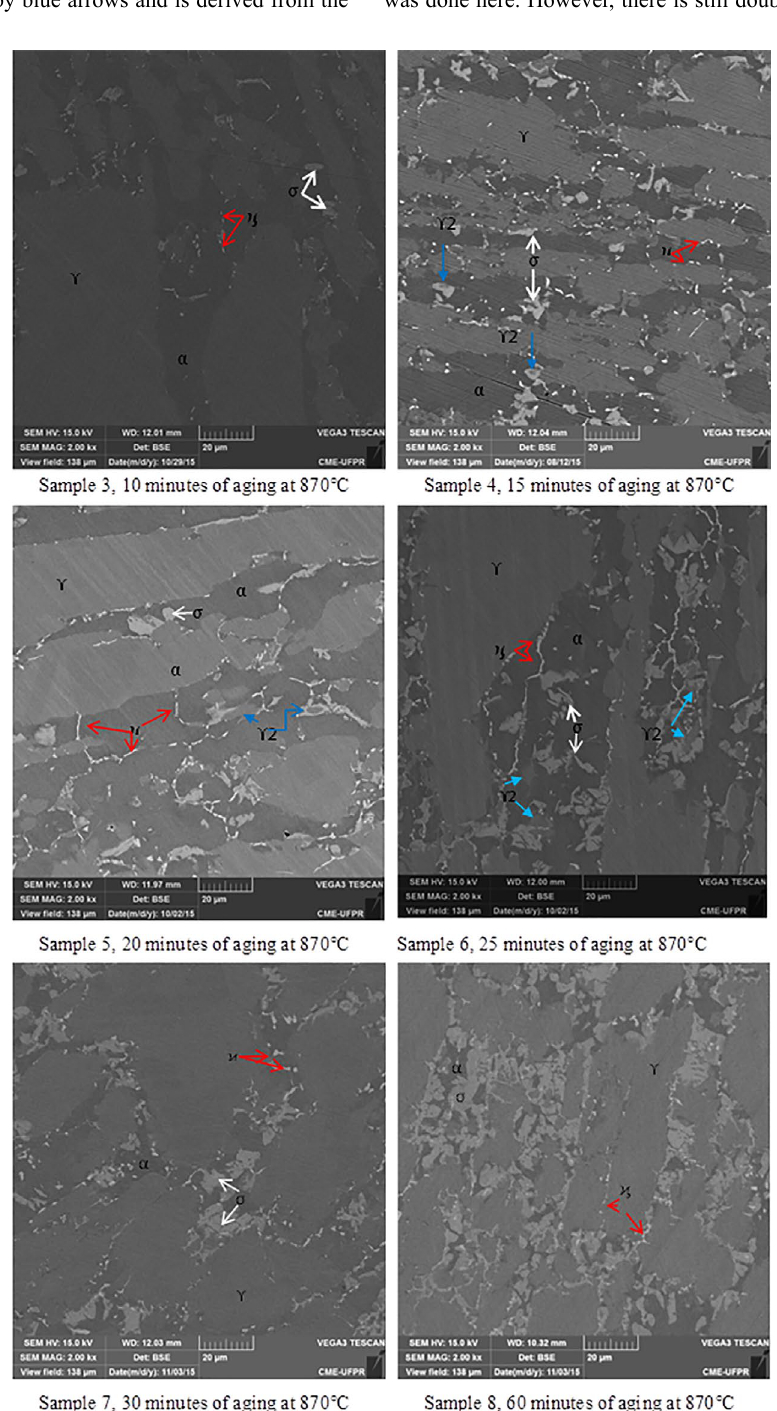
Figure 3. Microstructures of UNS S31803 steel aged isothermally at 870 in different times (Images by